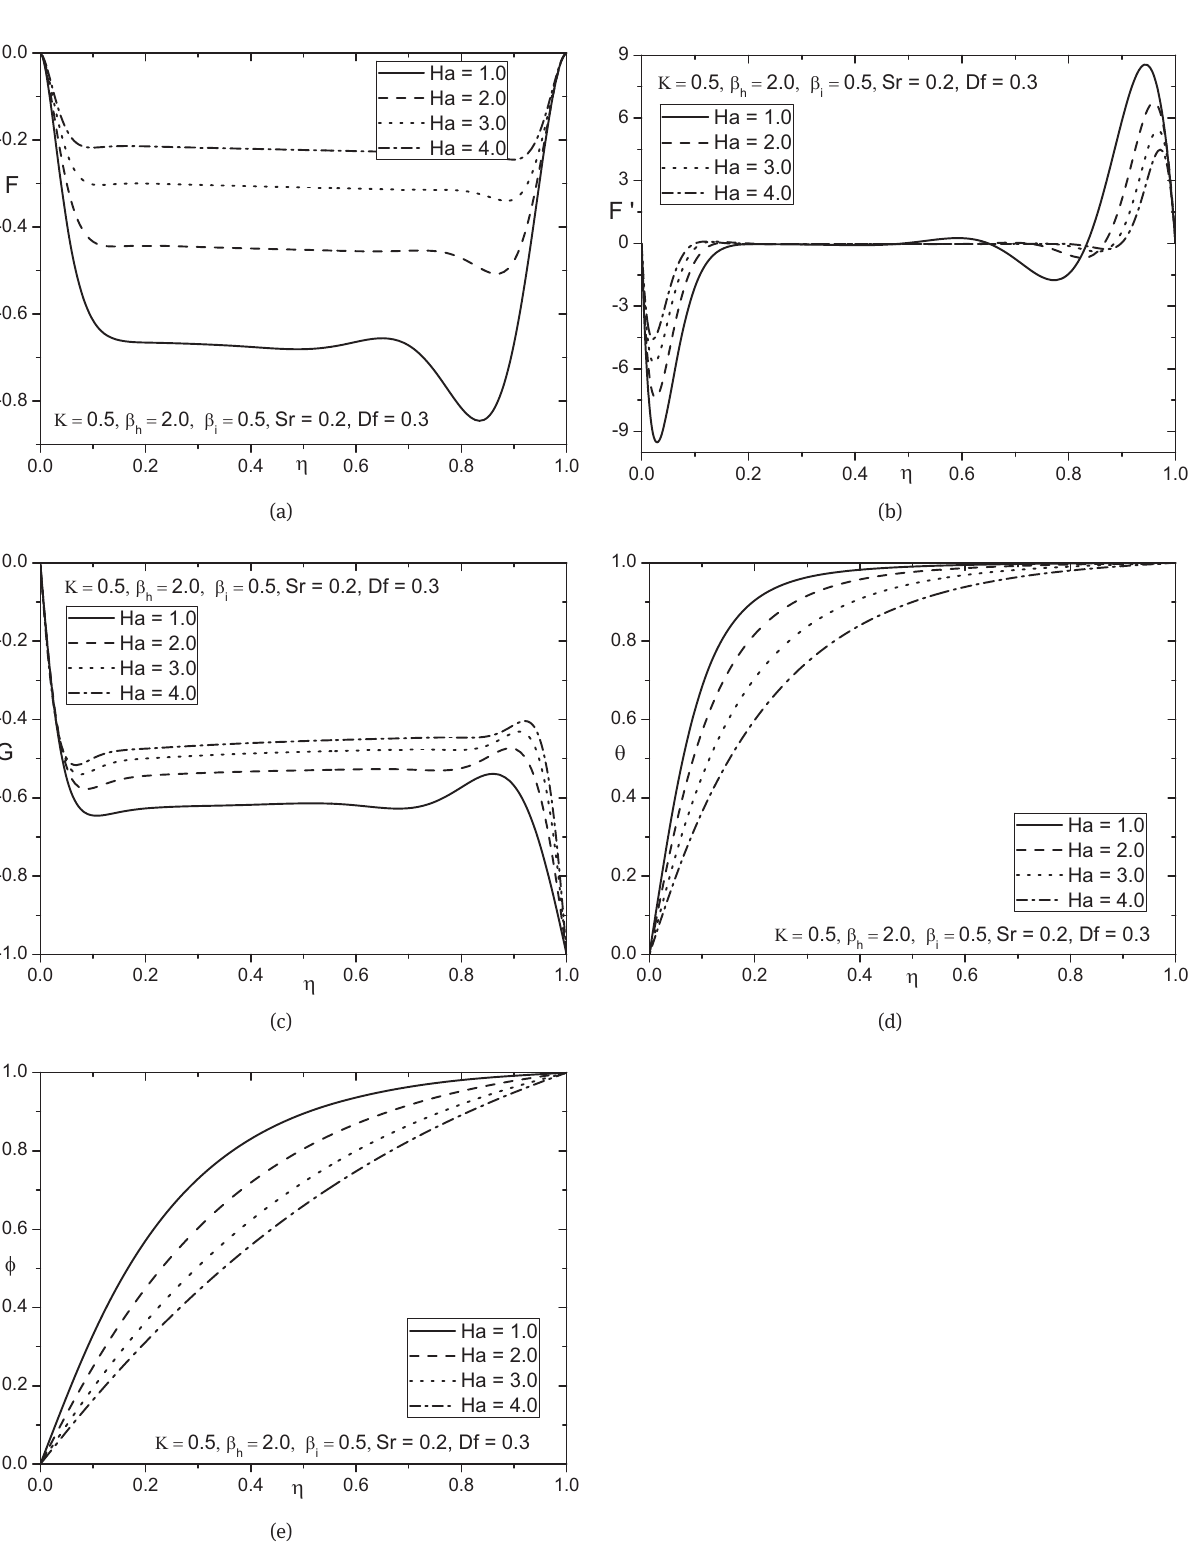
Fig. 2: Effect of Hartmann number on (a) axial velocity, (b) radial velocity, (c) tangential velocity, (d) temperature, and (e) concentration pro-